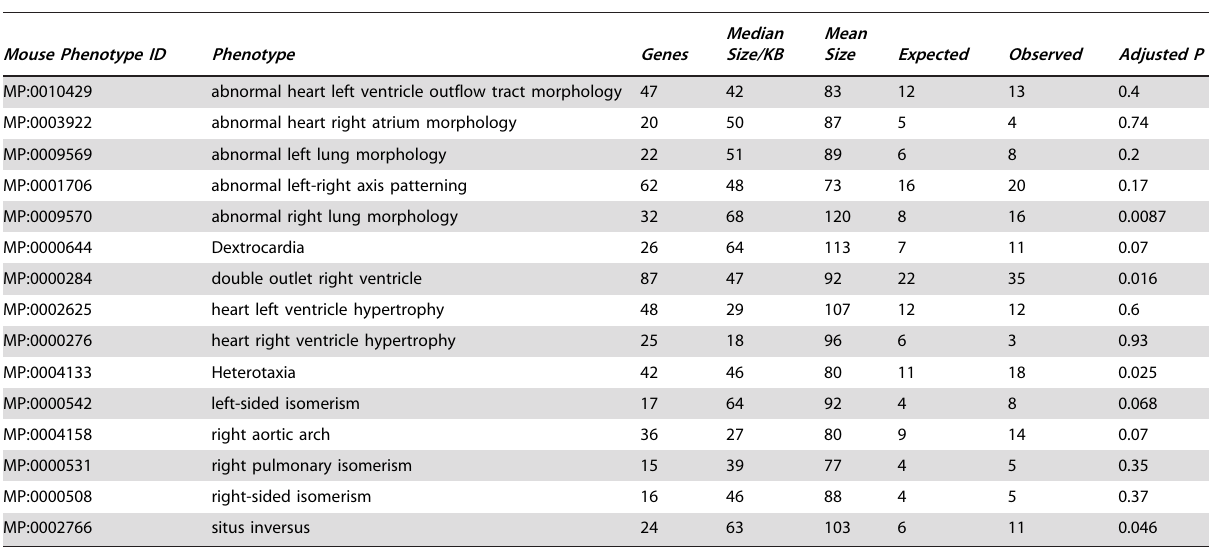
Table 4. In the relative hand skill GWAS meta-analysis of individuals with reading disability, there is an over-representation of highly associated SNPs within human orthologs of genes involved in causing LR asymmetry phenotypes when knocked out in